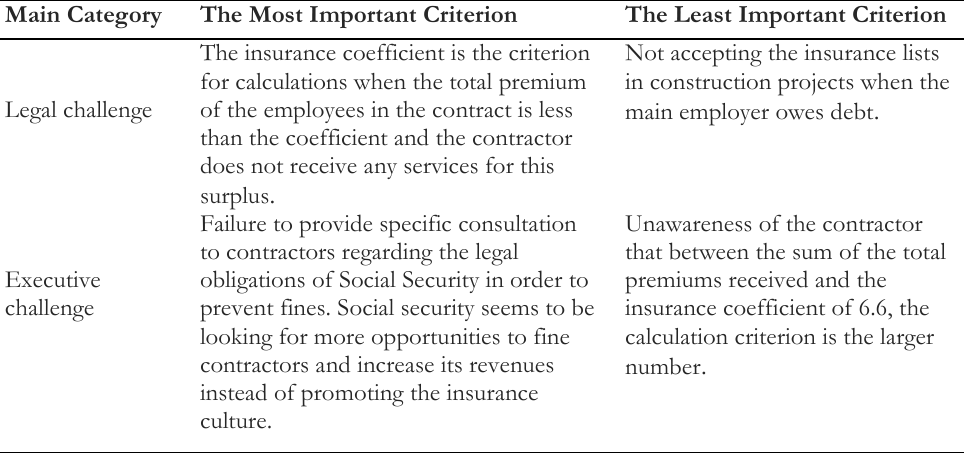
Table 4. The best and the worst